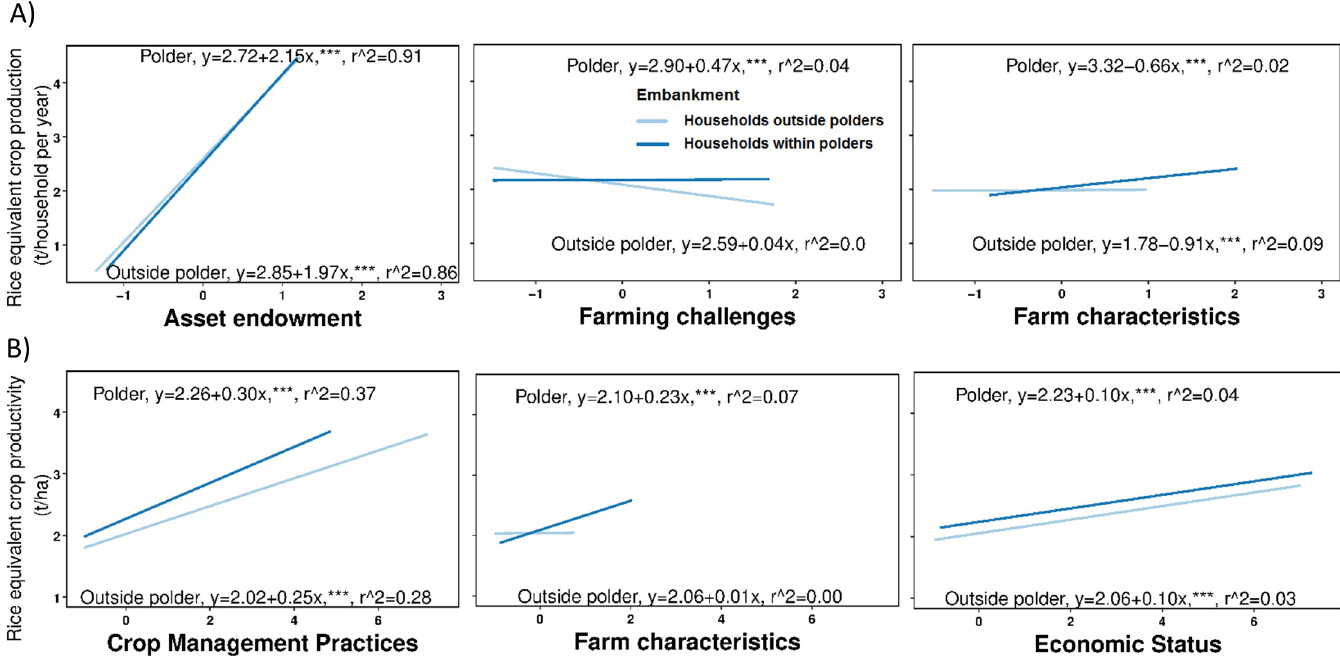
Fig 5. Relationship between influential factors and farm-level crop productivity for households within and outside polders (at 95% confidence level). A) Model predictions showing the effect of the three most important factors on household total annual crop production in terms of rice equivalent yield (REY), B) Model predictions showing the effect of the three most important factors on household crop productivity per unit area (REY per ha).